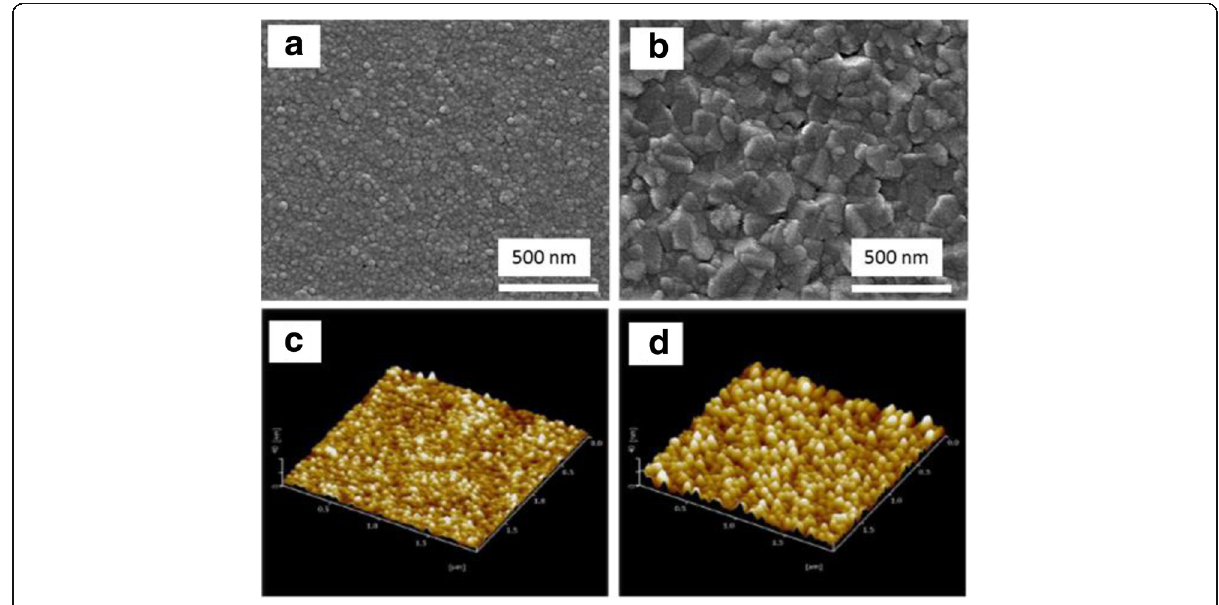
Fig. 2 SEM images of ( a ) as-deposited and ( b ) annealed MnZn ferrite thin film, ( c ) and ( d ) show the corresponding AFM